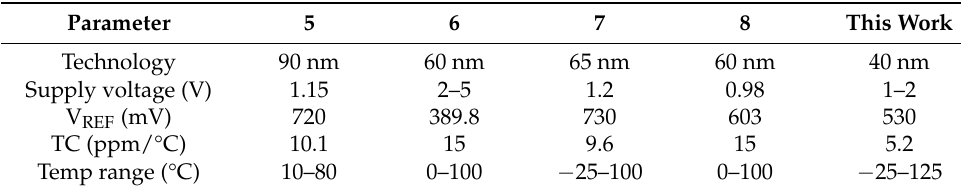
Table 1. Comparison of BGR in this article and previous